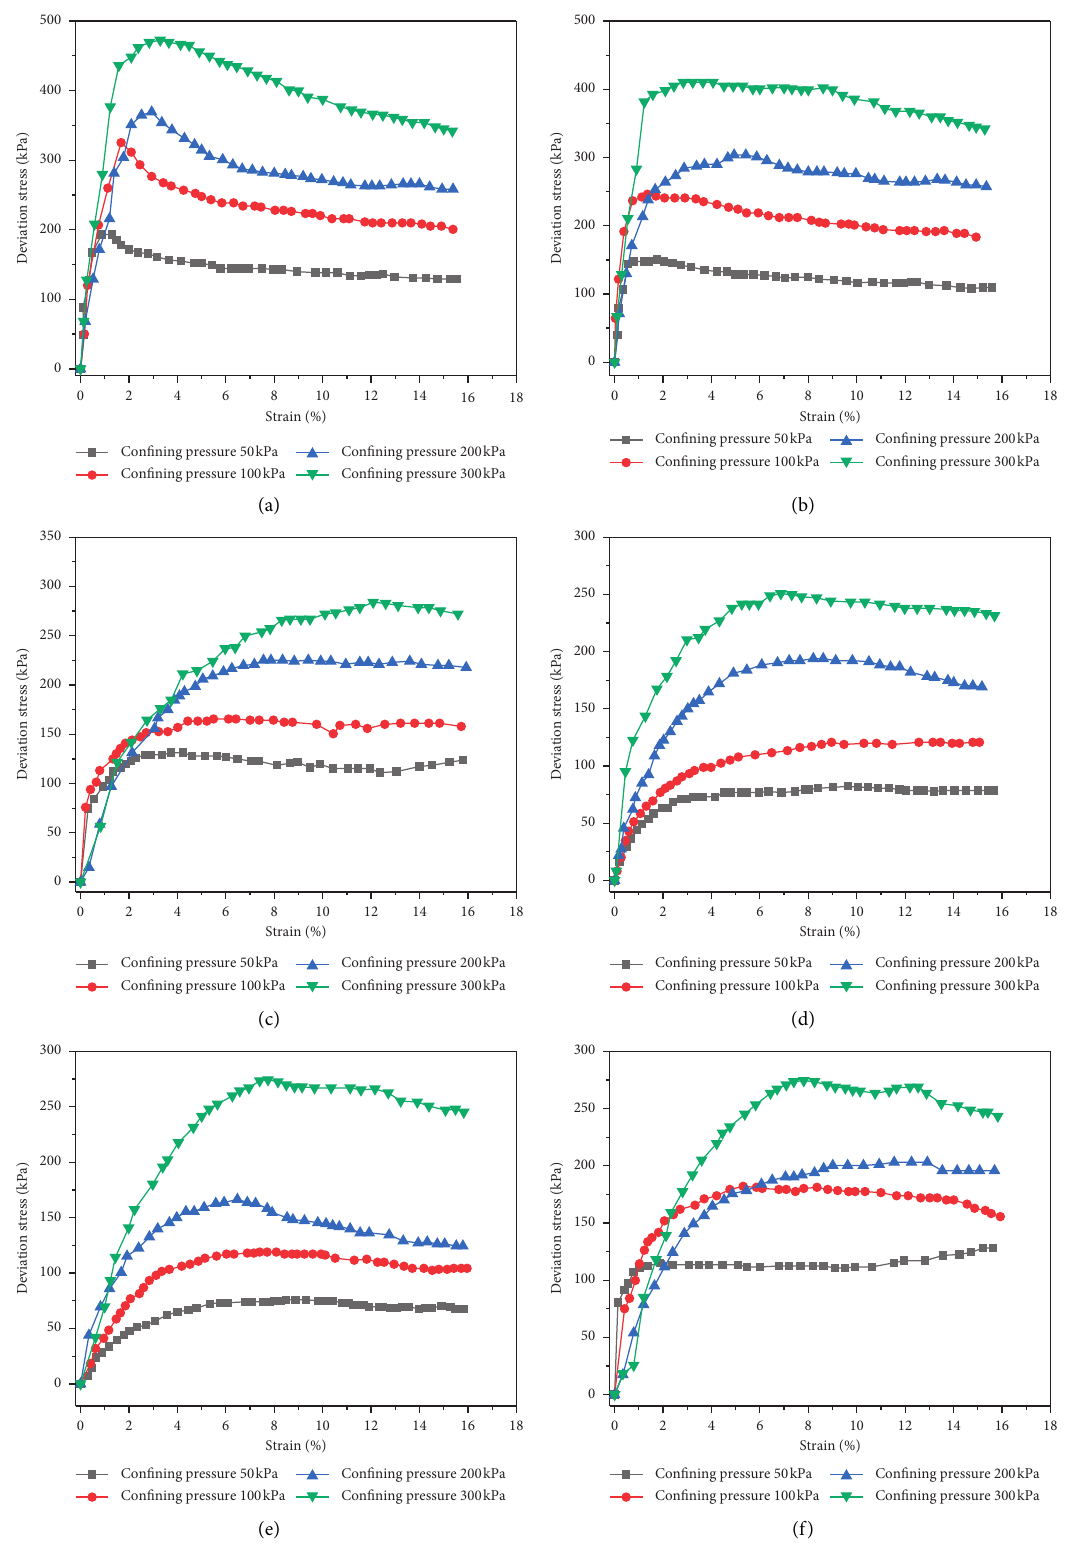
Figure 6: Stress-strain curves of the samples with an initial water content of w � 25% for different numbers of cycles. Moisture content w � 25% for (a) zero cycles. (b) one cycle, (c) two cycles, (d) three cycles, (e) four cycles, and (f) five